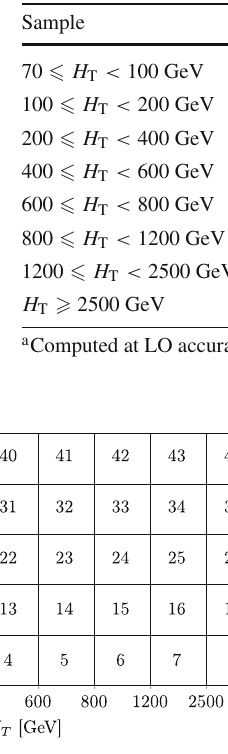
Fig. 2 Definition of the PS regions i in the plane of N jet versus H T , for the case of W+jets samples that are stitched based on the observables N jet and H